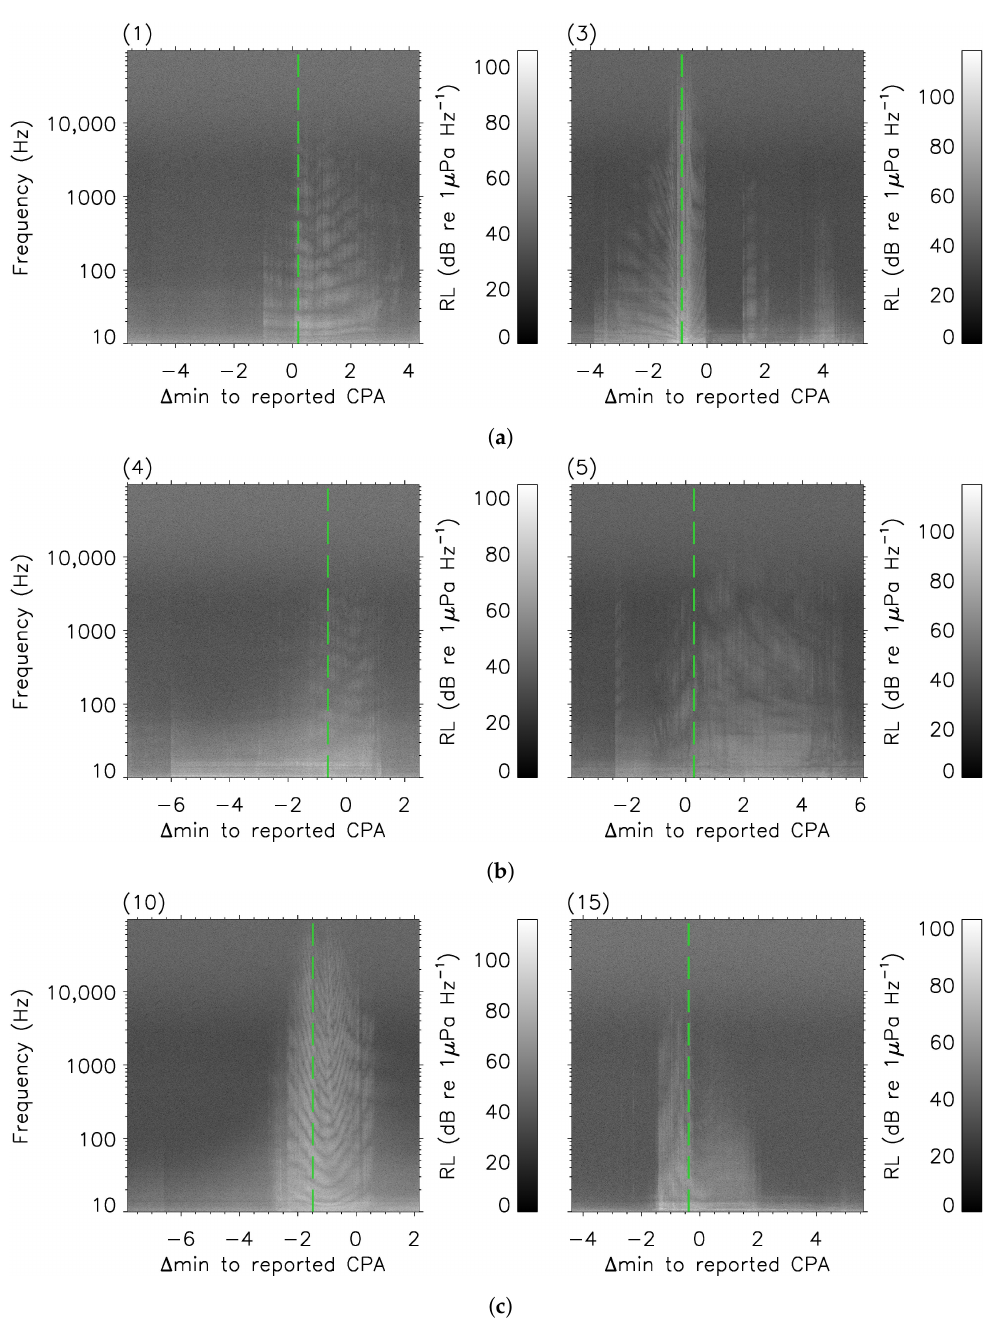
Figure 2. Examples of spectrograms for events of isolated recreational vessels during the 2021–2022 campaigns along the Saguenay River. The long-dashed vertical green line in each panel indicate the time of the highest signal integrated across the frequency domain. Slight offsets (typically < 60 s) between these vertical green lines and the reported times for the CPA passages (0 along the abscissa) in Table 1 are noted (see text). Negative (positive) ∆ min values indicate that the vessel was approaching (distancing) the hydrophone. Panels’ numbers refer to the vessels’ labels in Table 1. ( a ) Events 1 and 3; ( b ) events 4 and 5; ( c ) events 10 and